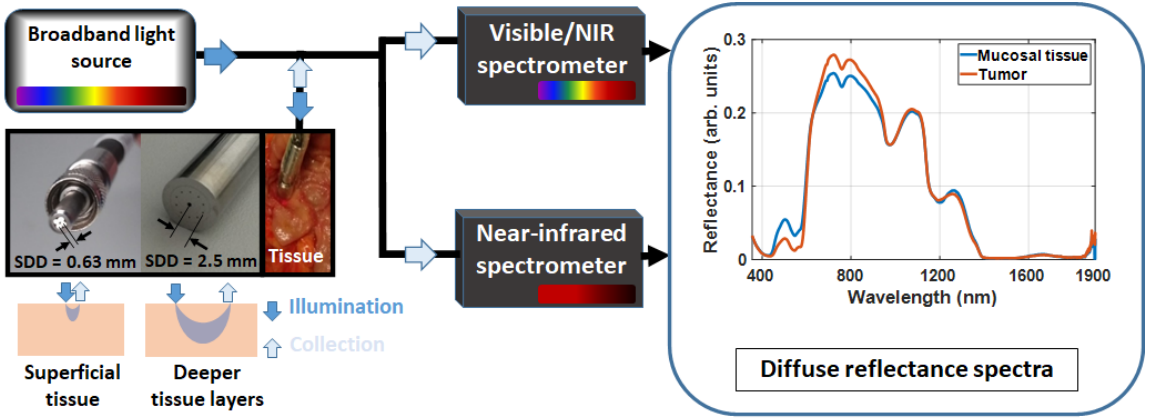
Figure 1. Schematic drawing of our DRS system. The obtained broadband reflectance contains information about a larger variety of tissue biomolecules compared to studies probing shorter wavelength ranges [61,86,87,102–111]. Broadband reflectance spectra were obtained by merging the visible and NIR spectra based on the overlapping spectral region between the two spectrometers (from 1090 nm to 1140 nm). The spectral merging procedure is described in detail in [11,12] and in Section 2.5. Briefly, in the overlapping spectral region, the two spectra are added with a smoothing weighting.